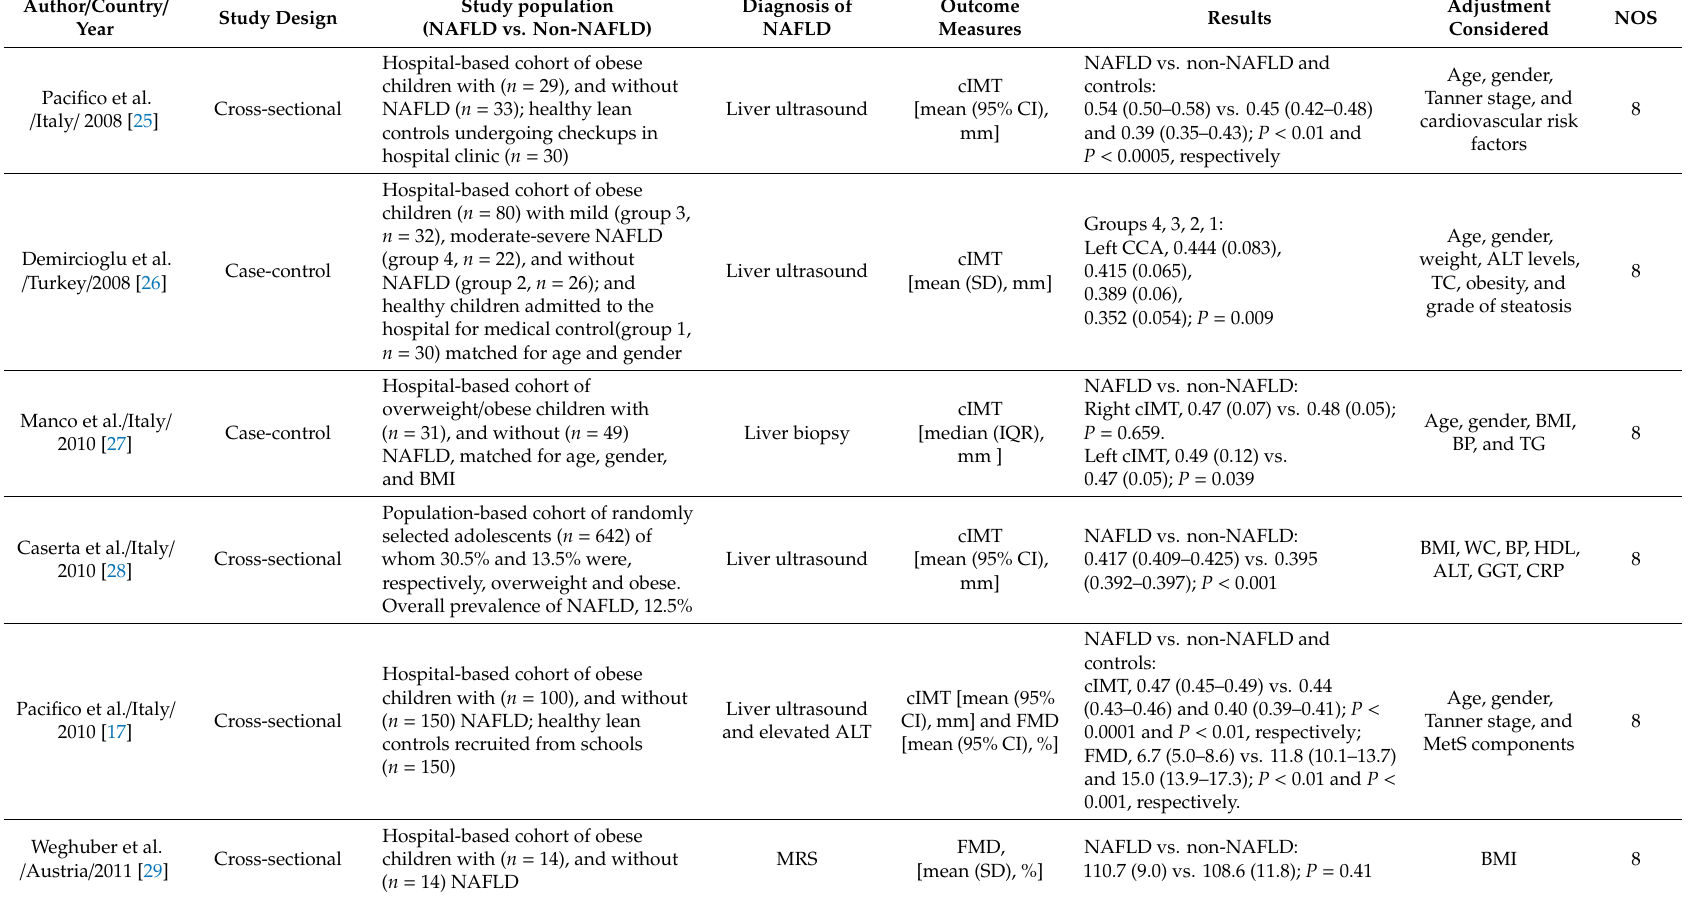
Table 1. Study characteristics for nonalcoholic fatty liver disease and